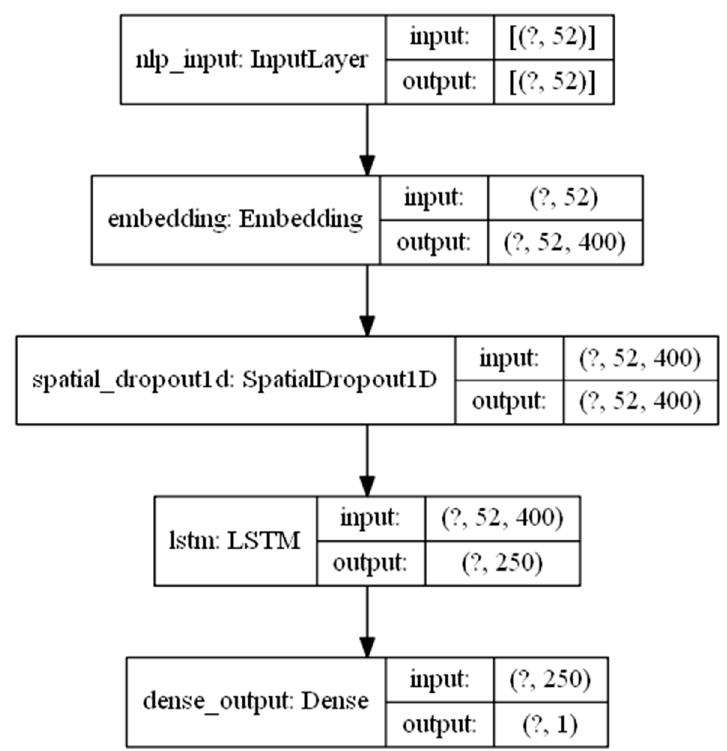
Figure 6. Architecture of the baseline: LSTM model.